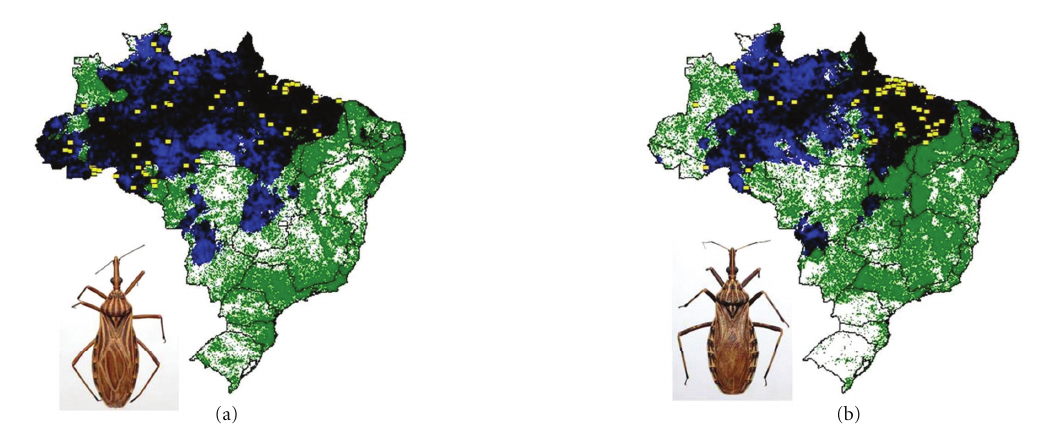
Figure 5: Ecological niche models projected as potential distributions for Amazonian triatomine species. (a) R. robustus, and (b) R. pictipes